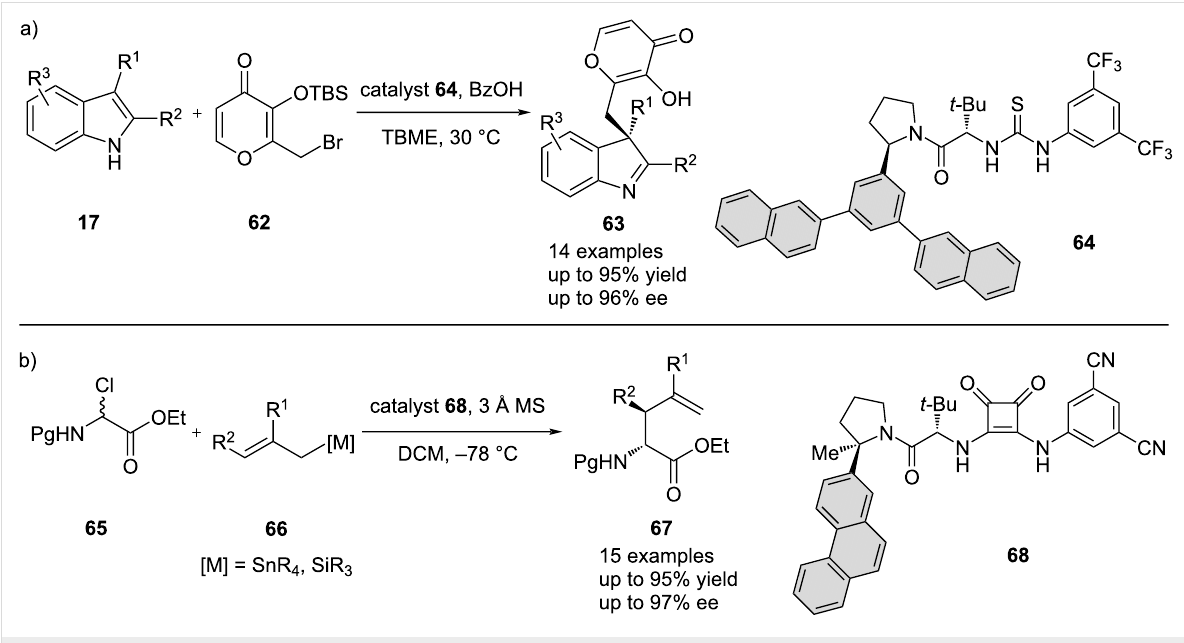
dition of indoles 17 to pyranones 62 (Scheme 14a) [71], as well as in the enantioselective synthesis of α -allyl amino esters 67 by the reaction of α -chloro amino acid derivatives 65 with allyltin and allylsilane 66 nucleophiles [72] (Scheme 14b). In both cases, an extended π -system on the side chain of the chiral